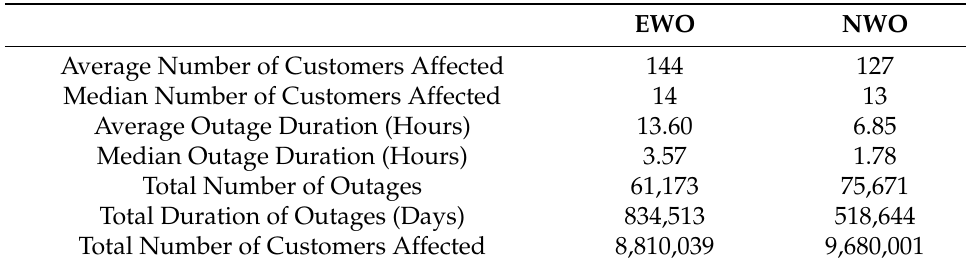
Table 1. Comparison of Extreme Weather outages (EWO) and Non-Extreme Weather outages (NWO) in MA based on the outage data from 2013–2018. Source: statistics are based on data obtained from MA department of public utilities